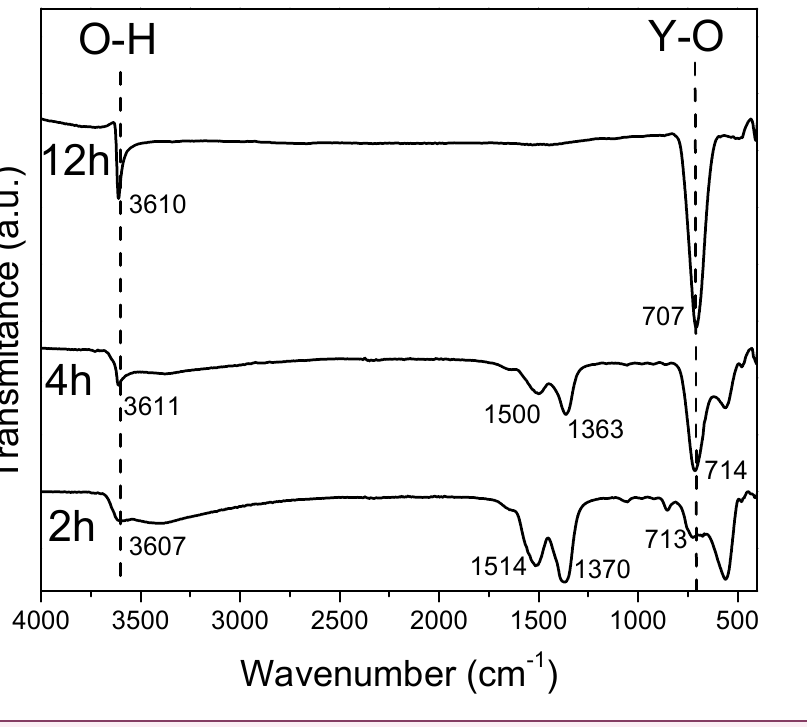
Figure 1 FTIR spectra of the sample obtained at 2 4, 12 hours.